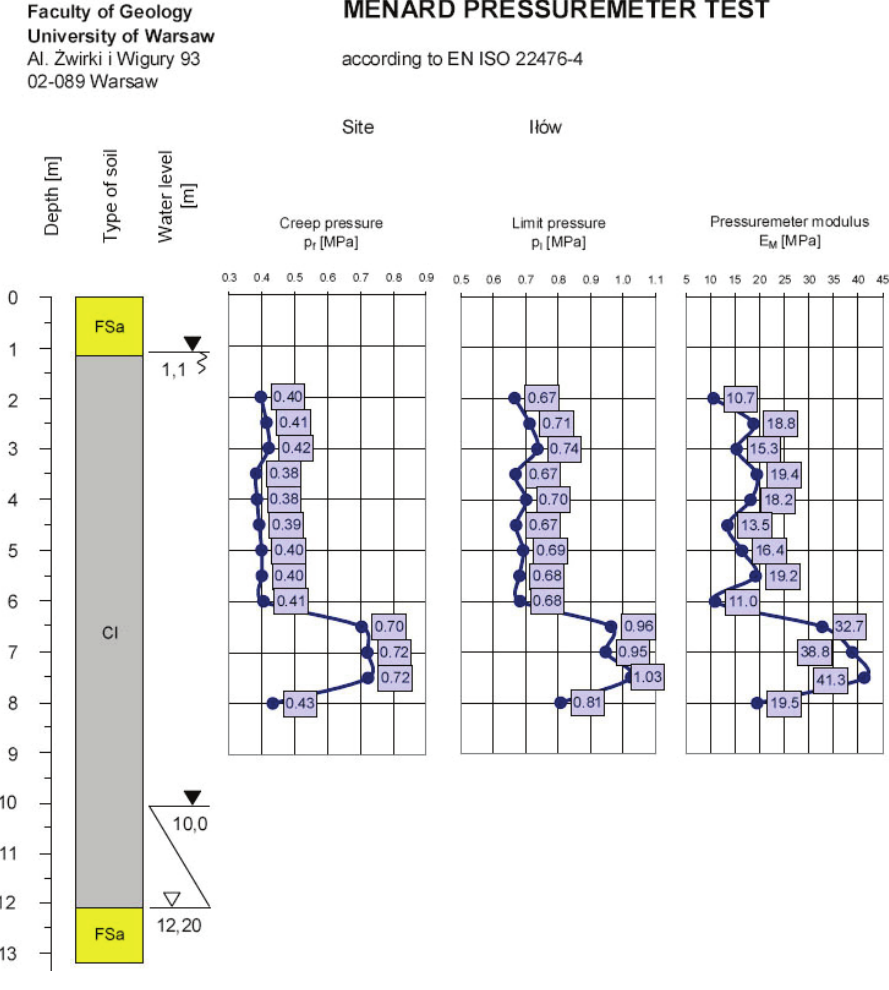
Fig. 7. Summary of pressuremeter tests results